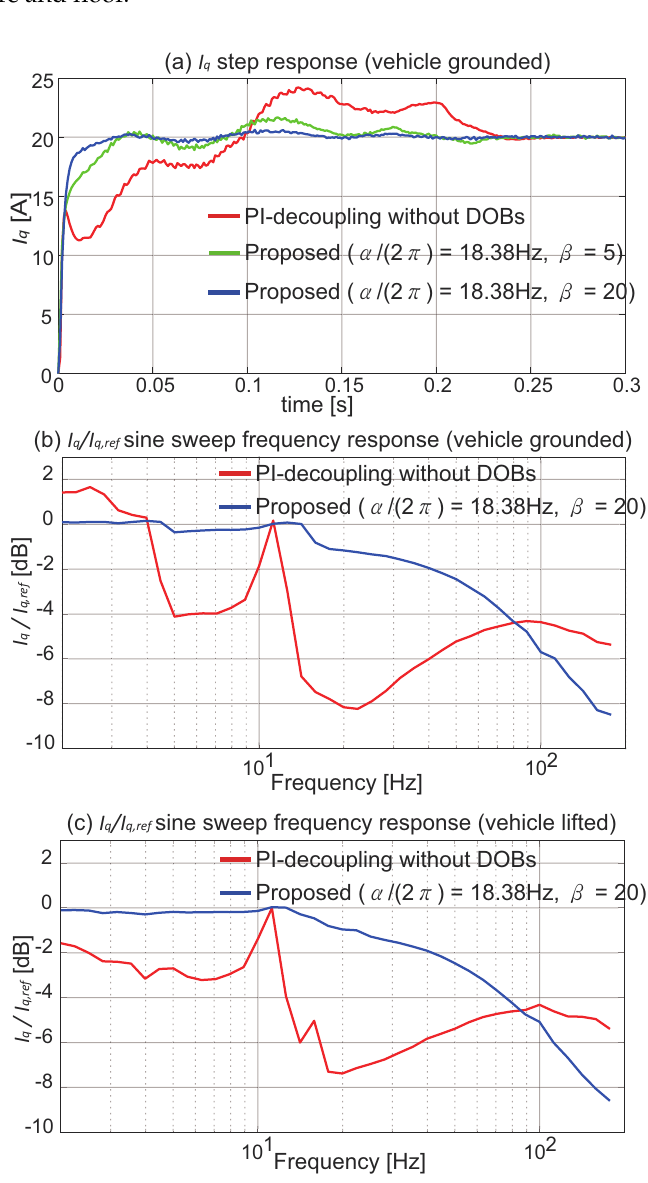
Figure 13. Experiment 1: q -axis current responses ( a , b ) when the vehicle is on the ground; and ( c ) when the vehicle is